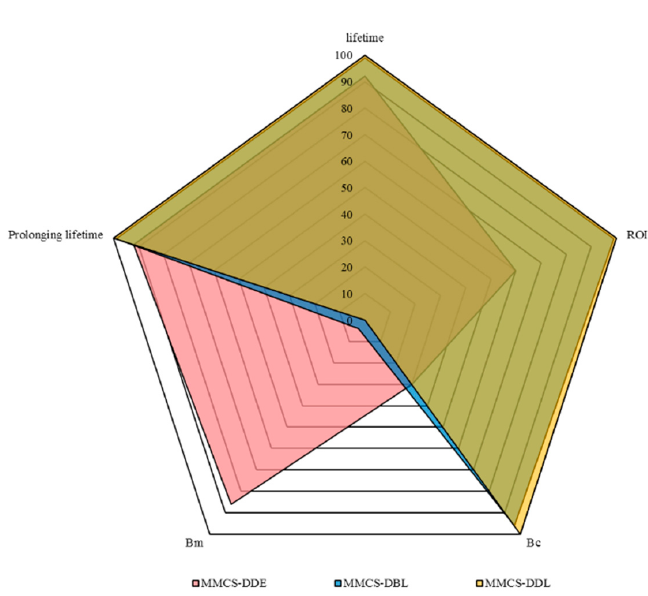
Figure 14. Comprehensive comparison.